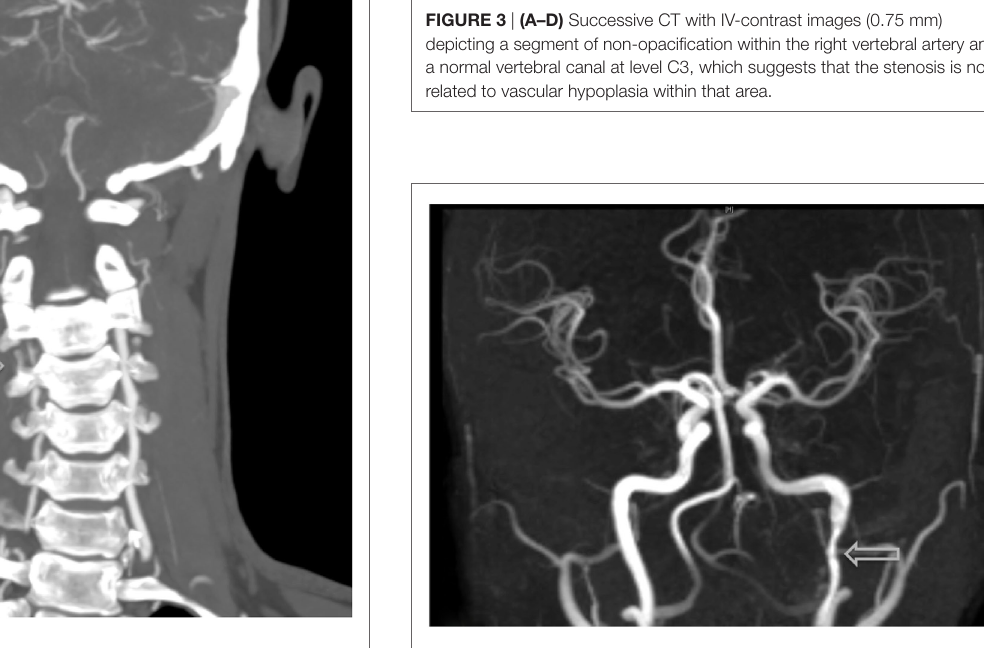
FIgURe 4 | Visualization of an additional dissection noted within the left-internal carotid artery on MRI angiography, an examination which was prompted due to the onset of acute headaches.